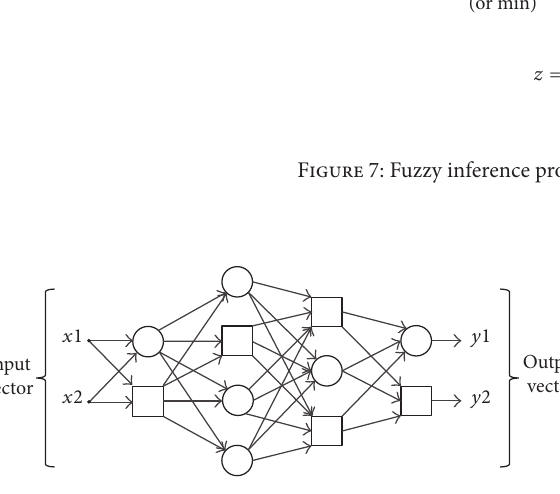
Figure 8: A typical adaptive